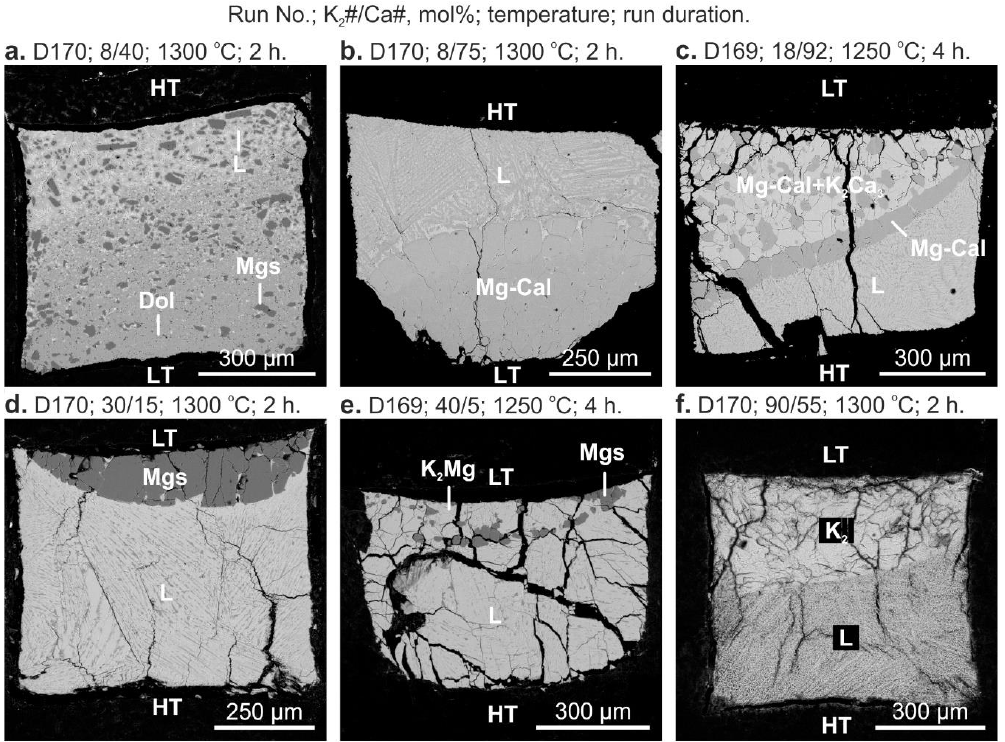
Figure 4. BSE images of sample cross-sections illustrating phase relationships in the system K 2 CO 3 −CaCO 3 – MgCO 3 at 6 GPa and 1250 – 1300 °C. K 2 #/Ca# indicates bulk composition of the starting mixture, K 2 # = 100∙K 2 CO 3 /(K 2 CO 3 + CaCO 3 + MgCO 3 ), Ca# =100∙CaCO 3 /(CaCO 3 + MgCO 3 ). LT — low- starting mixture, K 2 #